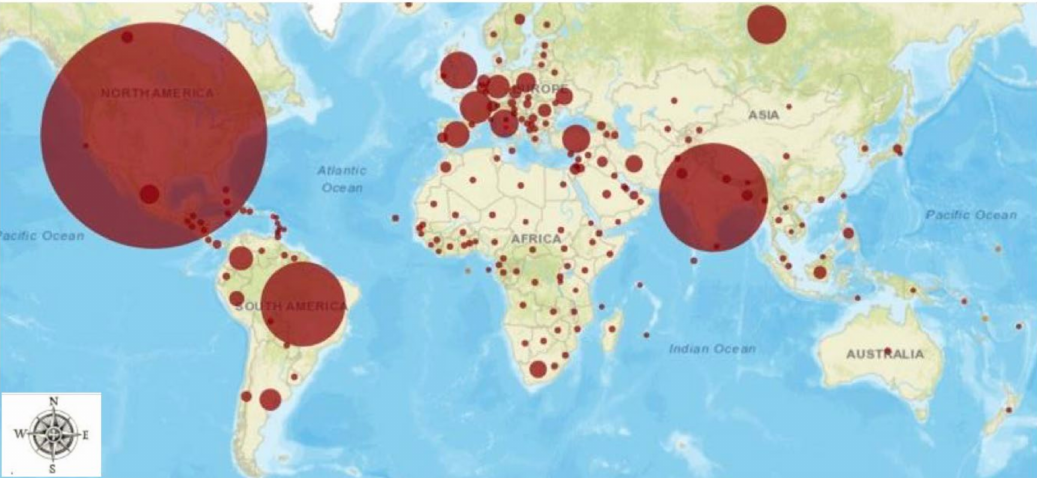
Figure 1. COVID-19 cumulative infection cases by country. The map of COVID-19 pandemic transmission shows the most affected countries at this time are the US, India, Brazil, the UK, and Russia, with a very slow infection rate in African countries (https://infographics.channelnewsasia. com/COVID-19/map.html, accessed on 30 November